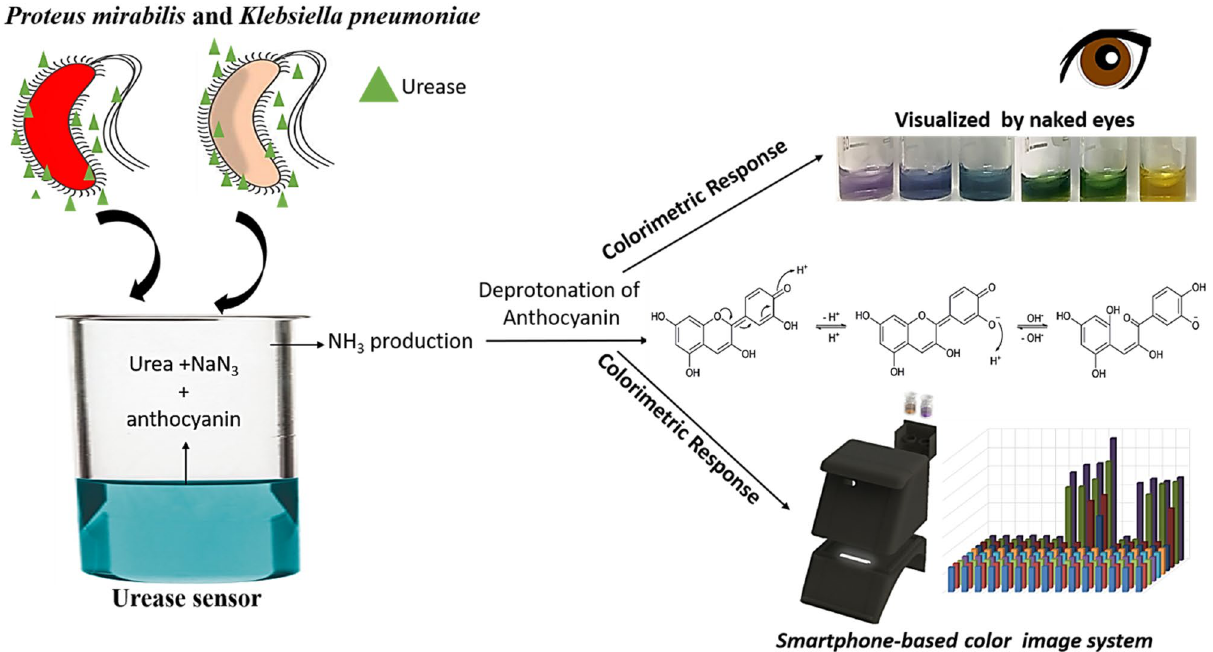
Scheme 1. Illustration of a novel and colorimetric urease test based detection of P. mirabilis and K. pneumoniae with a naked eye and smartphone